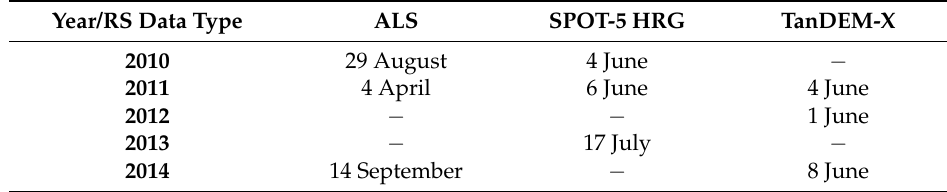
Table 2. A summary of the remote sensing (RS) data acquisitions used in the study. ALS: airborne laser